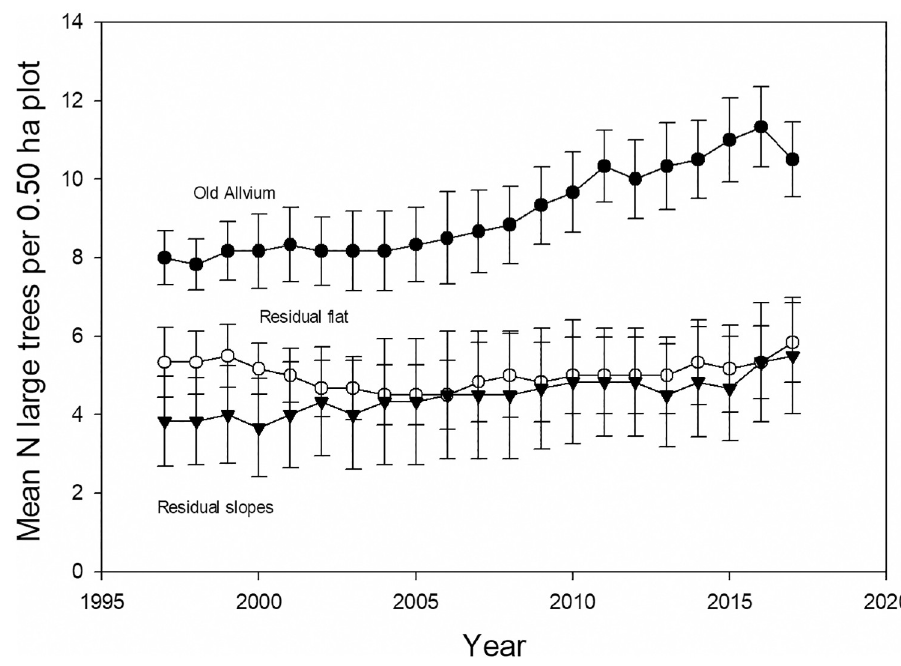
Fig 8. Large tree density by soil type. Mean number of large trees in 18 0.50 ha forest inventory plots in each of three dominant edaphic conditions in the old-growth tropical rain forest at the La Selva Biological Station, Costa Rica. N = 6 0.5-ha plots per treatment. Error bars are ± 1